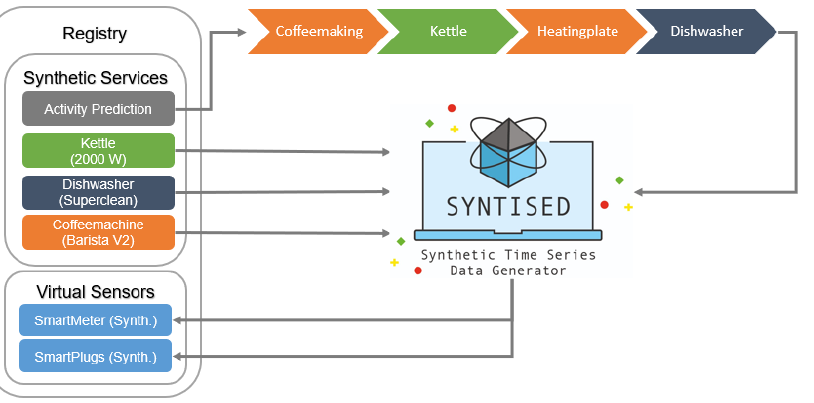
Figure 8. Architecture of synthetic generation of power consumption data with help of SynTiSeD , including services from the